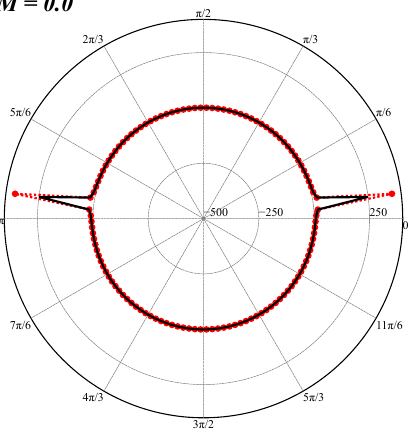
Figure 14. Polar distribution at r = 5 R 2 of the local adimensional impedance Z / Z 0 at ka = 3.4 in static condition. Results of Equation (5) (black line) are compared to the analytical value from Equation (25) (red dots).